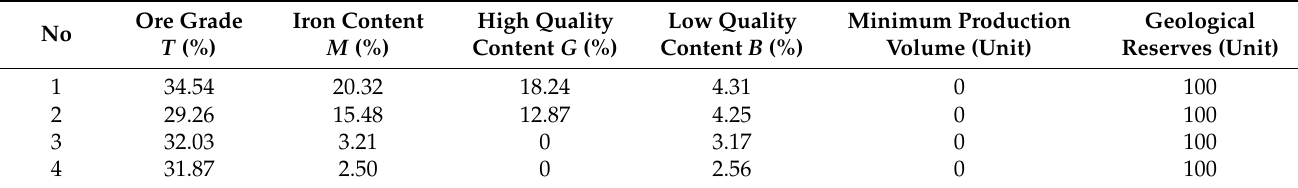
Table 4. The ore properties of each ore producing